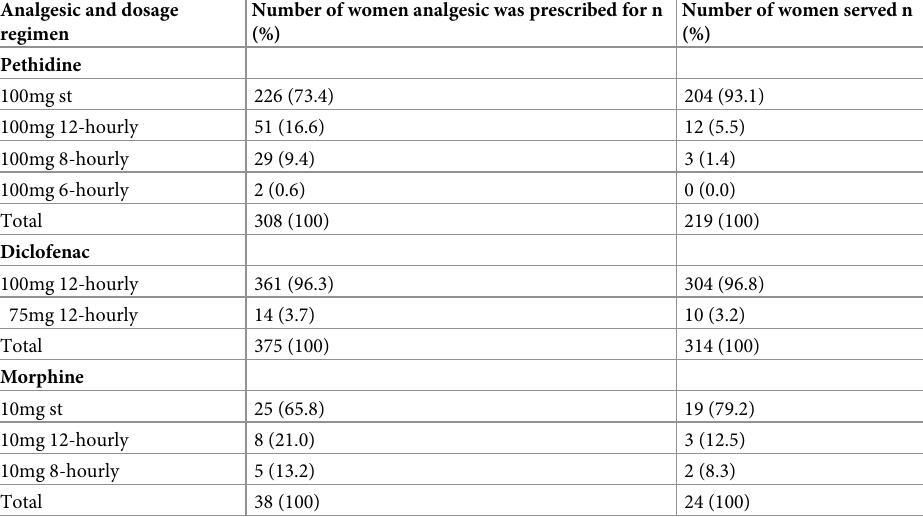
Table 2. Prescription and administration of analgesia for 24 hours